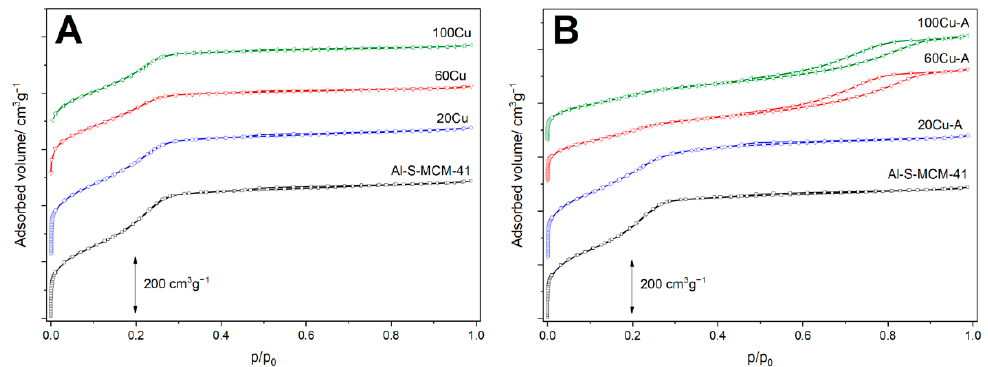
Figure 2. N 2 adsorption-desorption isotherms of the Al-S-MCM-41 sample and its modifications with copper obtained by TIE ( A ) and TIE-NH 3 ( B ) methods.